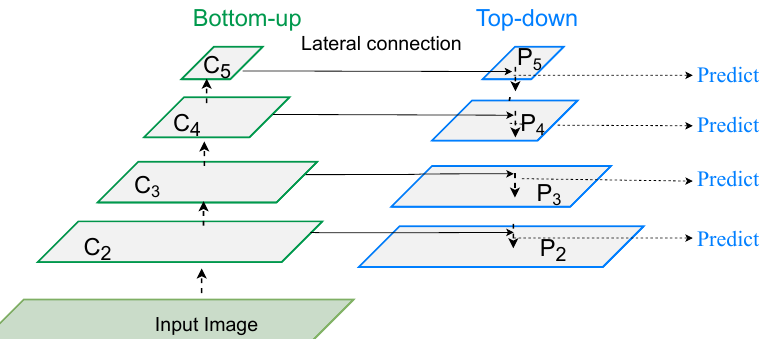
Figure 3. Visual illustration of the employed backbone and feature pyramid network. The backbone network extracts spatial features at multiple scales and propagates them to the corresponding FPN to learn various object